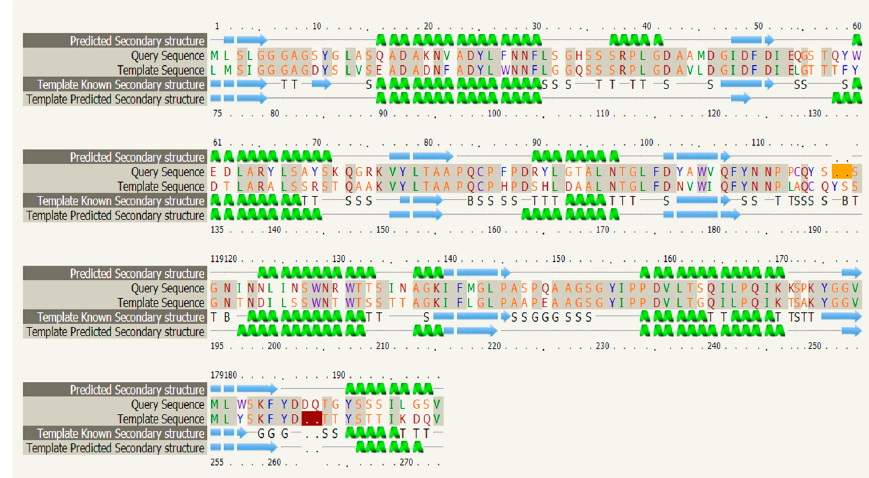
Figure 3. Prediction of secondary protein structure.